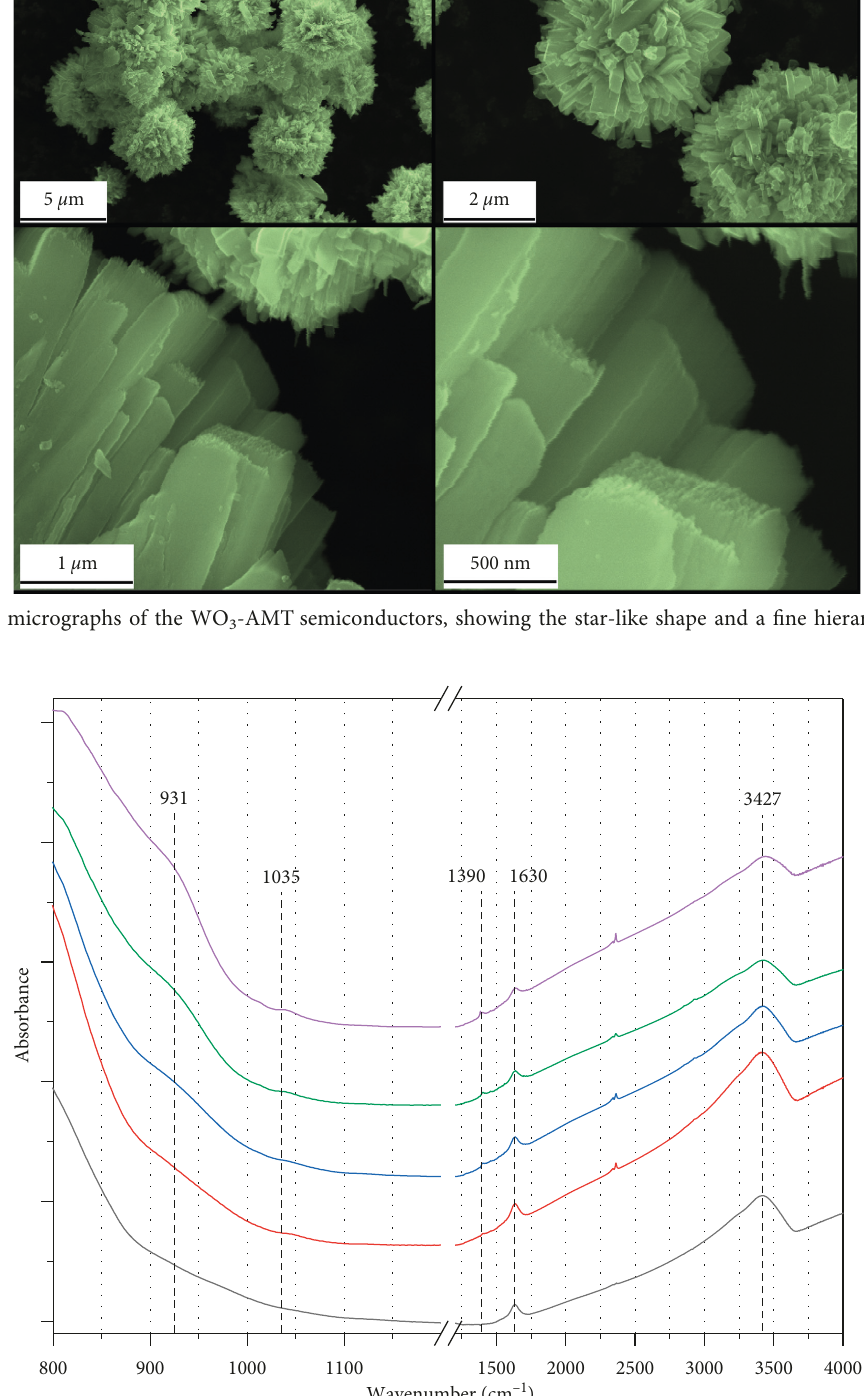
3 /TiO 2 composite